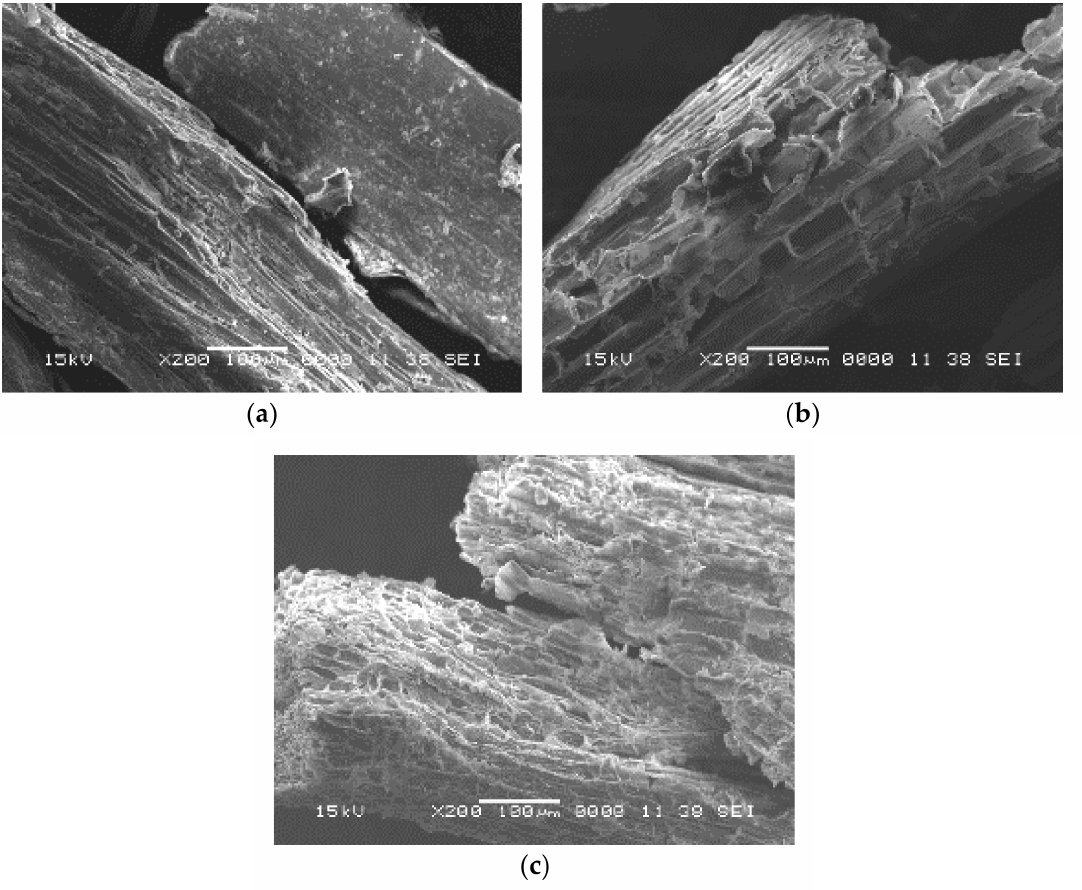
Figure 4. SEM images of ( a ) CS, ( b ) CSOU, and ( c )